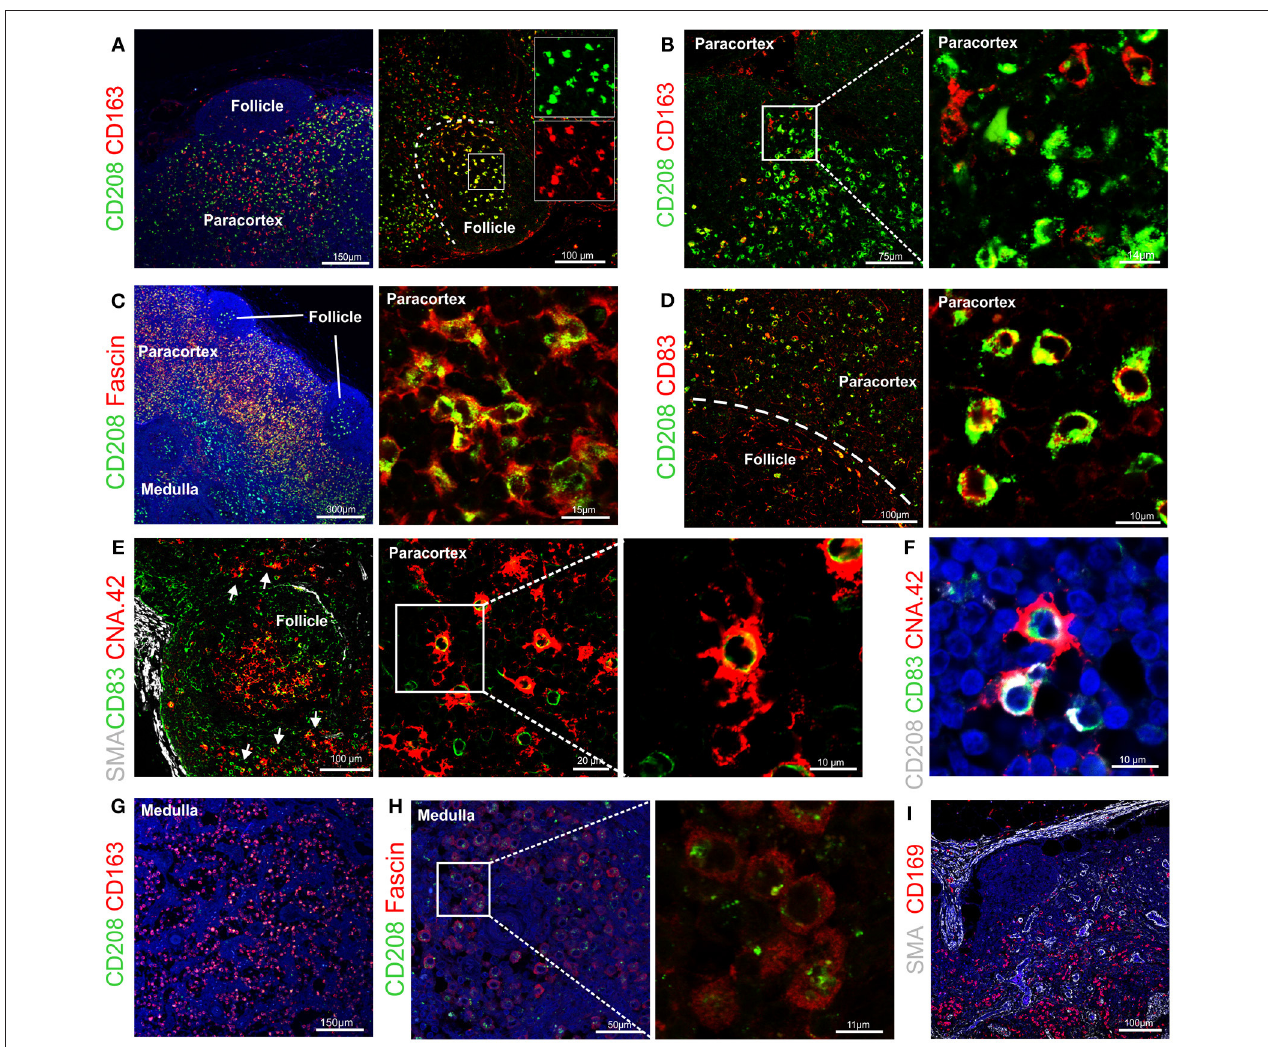
FIGURE 4 | Identification of markers for sheep antigen presenting cells. Representative confocal images of sheep lymph node sections. (A) Sections stained for CD163 (red) and CD208 (green) identify different populations of sheep phagocytes. In the follicle, colocalization (yellow) identifies tingible body macrophages. Inset: single color at higher magnification. (B) Sections stained for CD163 (red) and CD208 (green) in the paracortical area of the lymph node (LN) identify different cell-subsets. (C) Sections stained for fascin (red) and CD208 (green), both expressed at high levels in cells residing in the paracortical area. (D) Sections stained for CD208 (green) and CD83 (red). Both markers are expressed in dendritic cells residing in the paracortex. (E) Sections stained for CD83 (green) and CNA.42 (red) showing a population of CD83 + CAN.42 + dendritic cells in the paracortical area, smooth muscle actin (SMA, white) highlights the capsule of the LN. Inset: higher magnification. (F) Section stained for CD208 (white), CD83 (green), CNA.42 (red) to identify CD208 + CD83 + CNA.42 + dendritic cells. (G) Sections stained for CD163 (red) and CD208 (green), CD163 is mainly expressed in macrophages along the medullary sinuses. (H) Sections stained for fascin (red) and CD208 (green), macrophages in the medullary sinuses express low levels of the two markers. (I) Sections stained for smooth muscle actin (SMA, white), JAM-A (green) and CD169 (red). CD169 + macrophages are present along the trabecules but not in the subcapsular area.